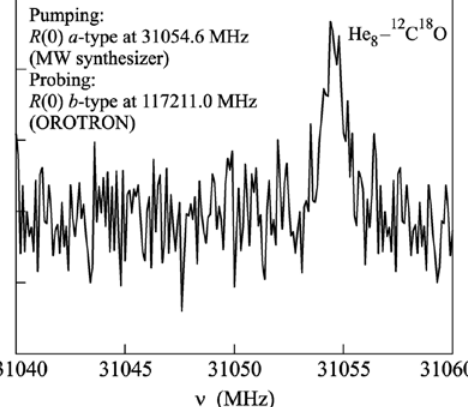
Fig. 2. Record of the R (0) transition in the He 8 – 12 C 18 O clus- ter by the double resonance method with OROTRON.